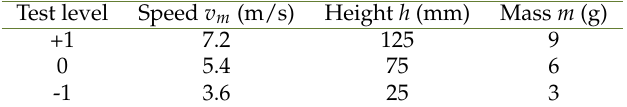
Table 2. Test levels and factors